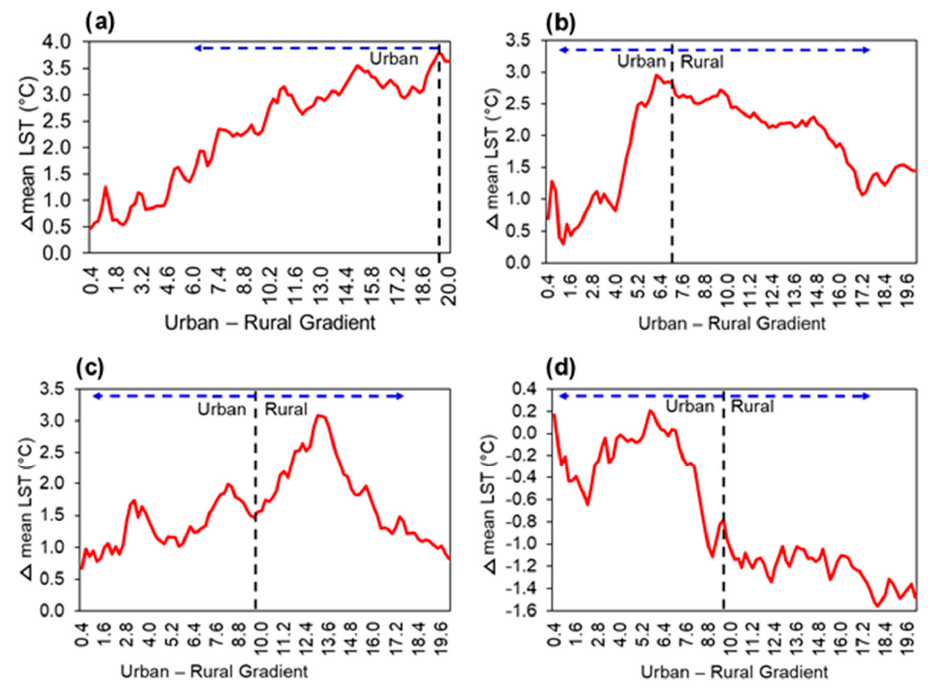
Figure 8. Urban heat island intensity ( ∆ mean LST) patterns along the urban–rural gradients of Lagos ( a ), Nairobi ( b ), Addis Ababa ( c ) and Lusaka ( d ). Note: Urban and rural were discerned based on the physical extent of the built-up footprint for each city.